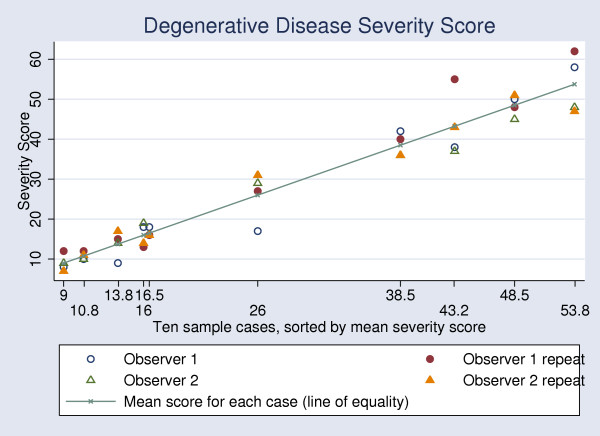
Degenerative Disease Severity Score. The degenerative disease severity score assigned by two observers for 10 sample cases. Score by Observer 1 highly correlates with the score given by Observer 2 and with repeat scores for each observer.